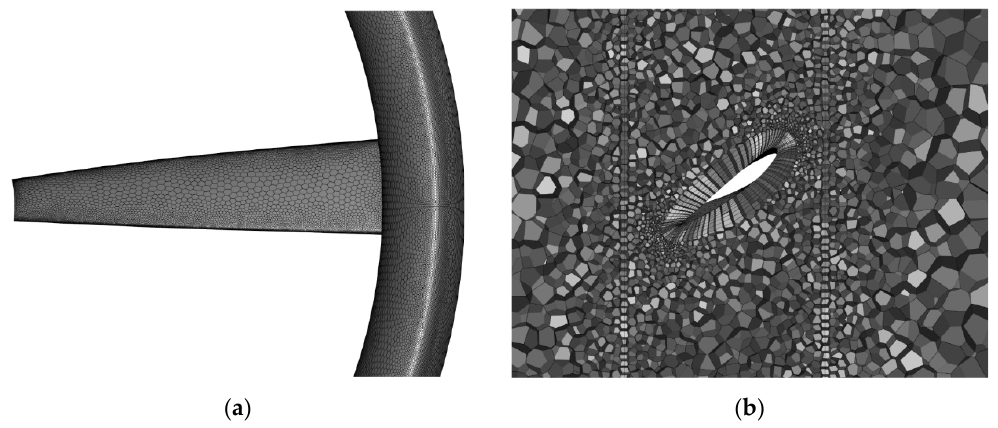
Figure 8. The medium mesh used in simulations: ( a ) surface mesh on blade and duct; ( b ) cross section mesh around blade.